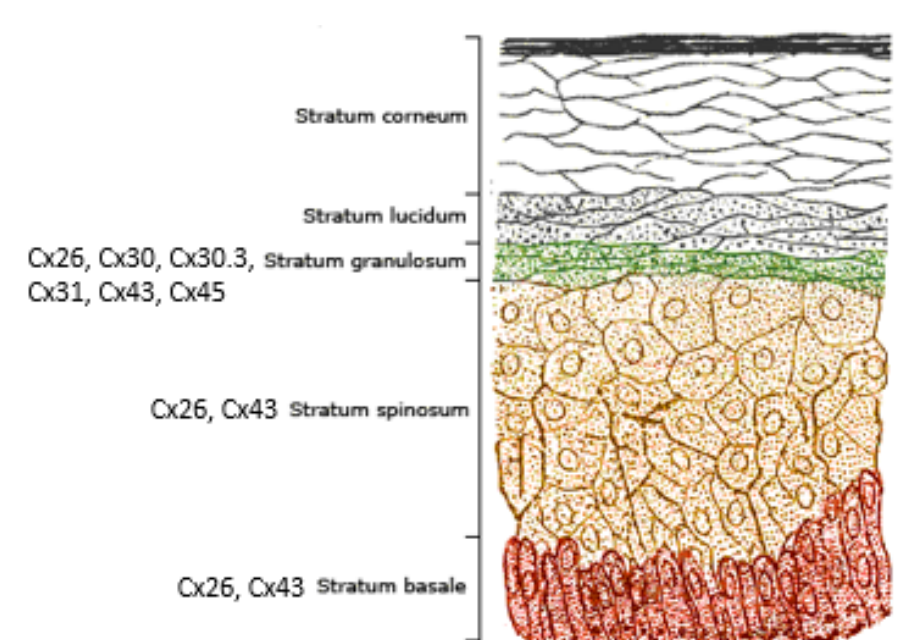
Figure 2. Illustration of human skin showing the progression and differentiation of cells from the stratum basale to the stratum corneum. Beta-type connexins include Cx26, Cx30, Cx30.3, and Cx31 which are co-expressed in the stratum granulosom. In addition, Cx26 is expressed throughout the layers of the epidermis along with Cx43 an alpha-type connexin. Image from Wikipedia.or modified to include connexin expression results from [3].